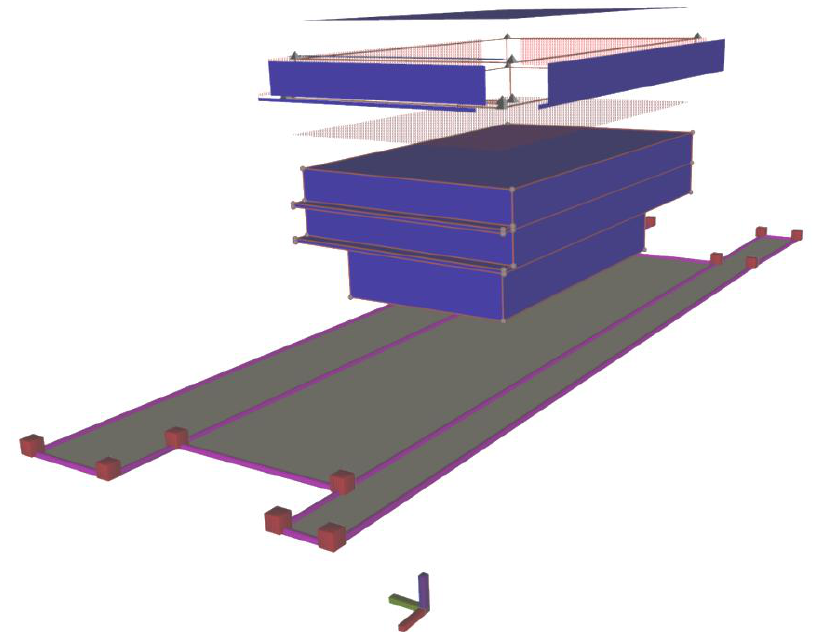
Figure 3. A cartographically enriched 3D cadastre scene based on a virtual DLM. The building is upward offset from the land parcel, and the fourth floor (a privately owned space) is upward offset from the building. Each of the fourth floor’s surfaces are offset towards the outside.